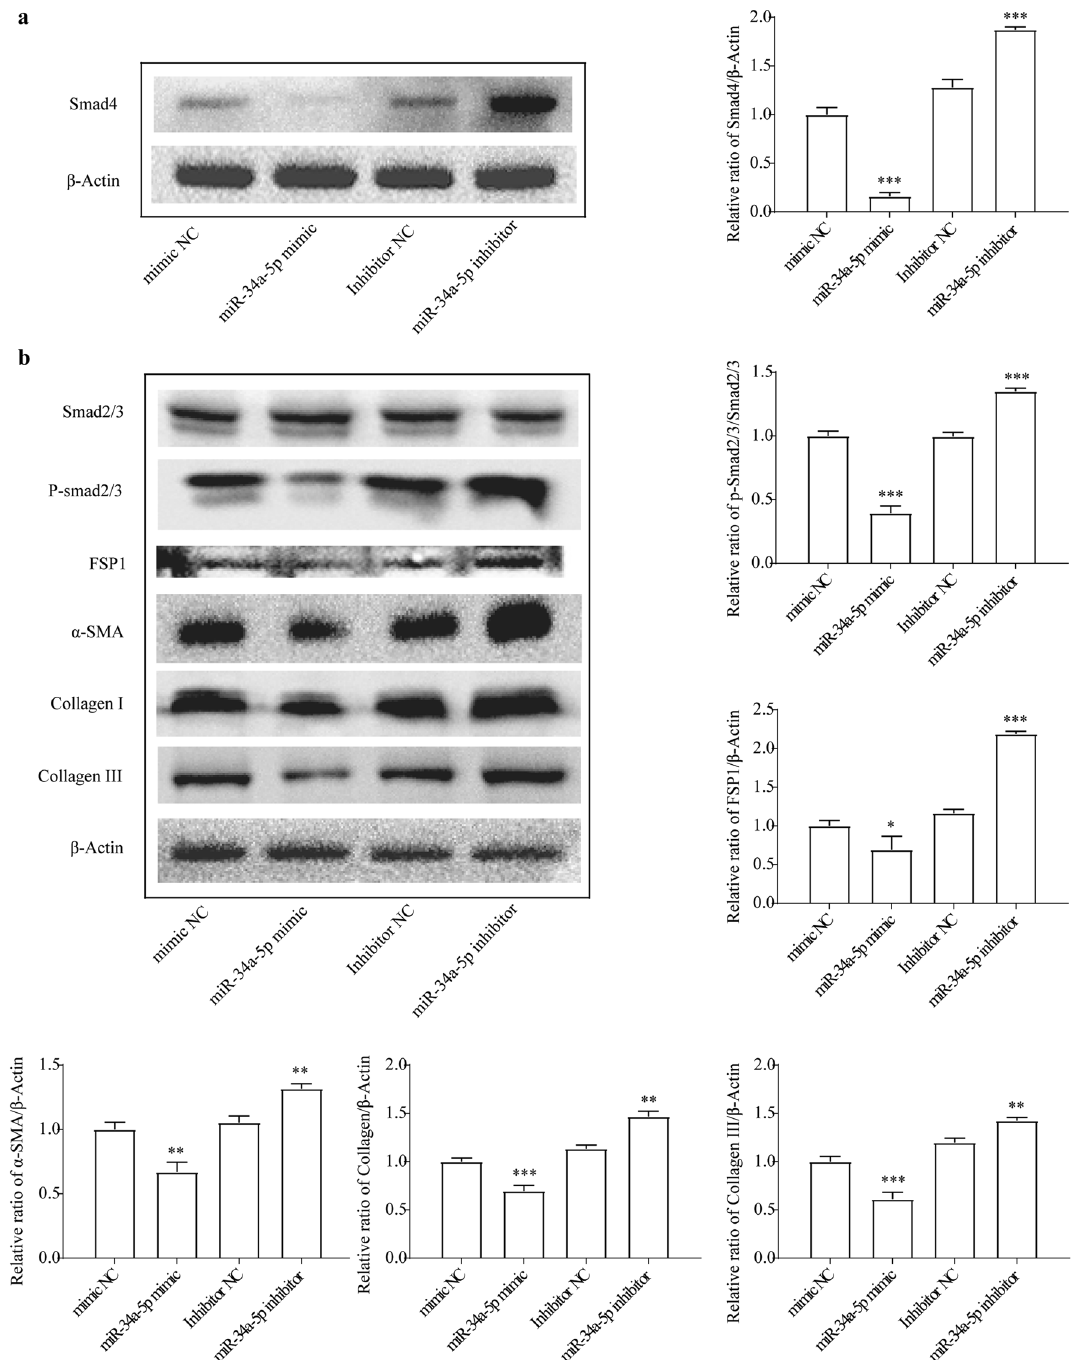
Figure 5. miR-34a-5p controls level of ECM related proteins and Smad signaling in HSCs. ( a ) Smad4 protein level changed after miR-34a-5p mimic and inhibitor treatment. ( b ) Smad signaling and ECM related proteins level changed after miR-34a-5p mimic and inhibitor treatment.*, p < 0.05, ** , p < 0.01,***, p < 0.005. β-actin was used as an internal control. Data are reported as means ±